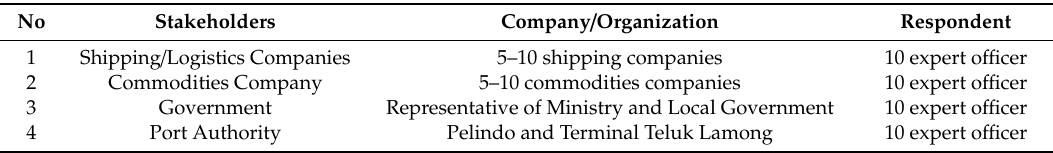
Table 3. Respondent data for questionnaire